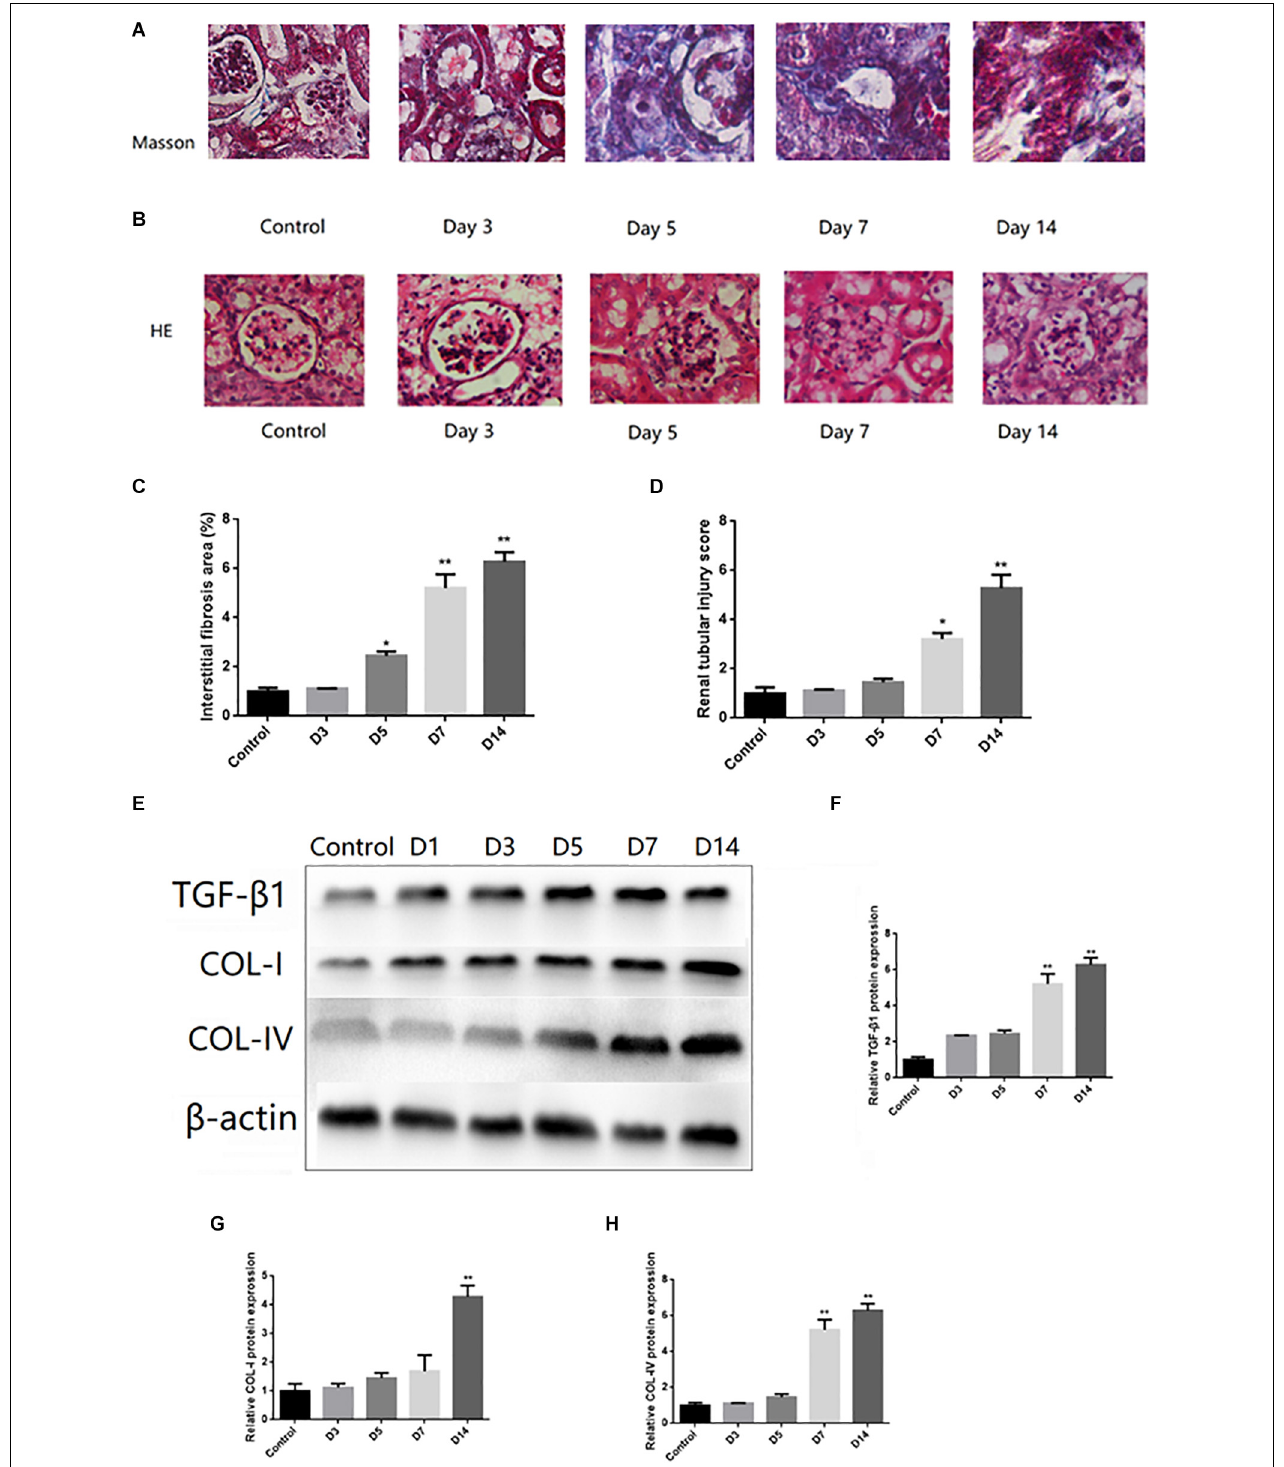
FIGURE 1 | Histological changes and activation of TGF- β 1 signaling pathway in UUO mice. (A) Representative images of Masson trichrome staining of kidney of UUO (Masson trichrome, × 400). (B) Representative images of renal tubular injury of kidney of UUO (H&E, × 400). (C) Quantitative analysis of tubular interstitial fibrosis from Masson trichrome staining results. (D) Quantitative analysis of tubular injury from HE staining results. (E–H) The protein expression levels of TGF- β 1, COL-I, and COL-IV were tested by Western blot analysis. ∗ P < 0.05 versus Control; ∗∗ P < 0.01 versus Control.